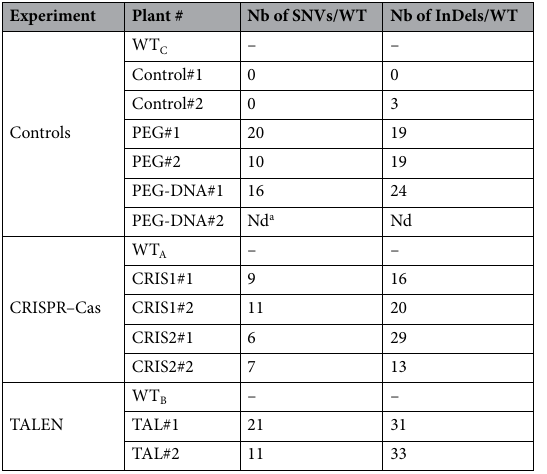
Table 2. Whole genome sequence analysis and variants detected in each plant. a Not determined (nd). DNA sample from the PEG-DNA#2 plant was suspected to be contaminated. The sequence obtained from this sample could not be used for the analysis of variants.